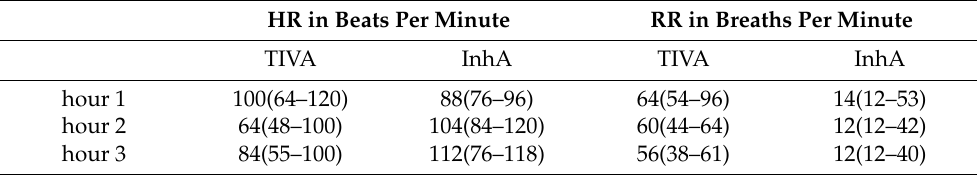
Table 2. Frequency of heartbeats and breaths per minute in sheep during anaesthesia for laparotomy. HR in Beats Per Minute RR in Breaths Per Minute TIVA InhA TIVA InhA hour